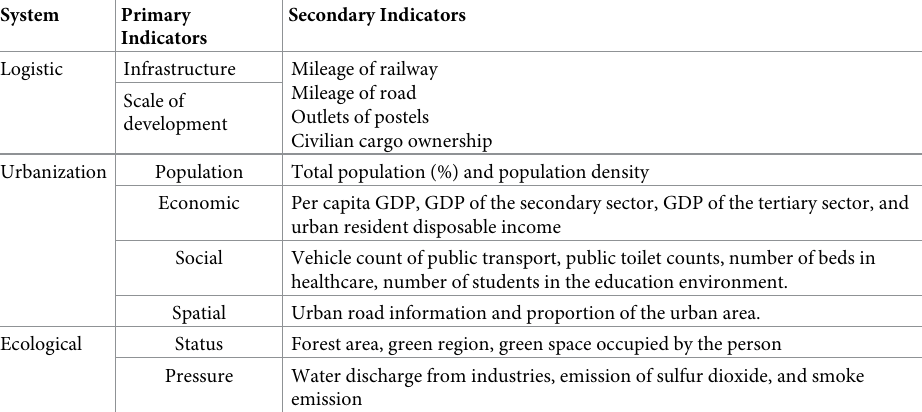
Table 1 based collected indicators is collected from the Yangtze River Economic Belt region [24]. The Yangtze River Economic Belt dates back to the 1980s, when it was suggested as an extension of the Yangtze River Industrial Concentration Zone. The region has 11 cities: Table 1. Indicators utilized in the region’s economic level